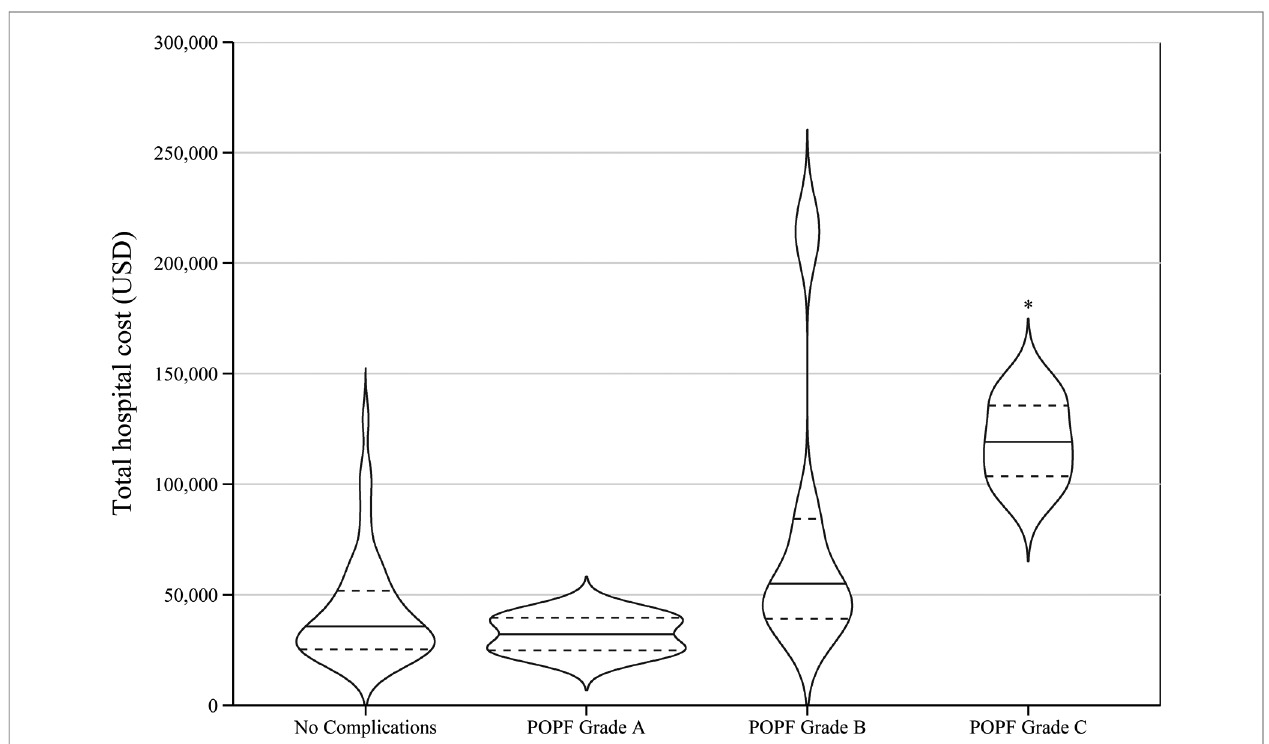
FIGURE 4 | Unadjusted hospital cost according to the grade of postoperative pancreatic fi stula. The pancreatic fi stula is graded in agree with the International Study Group for Pancreatic Surgery de fi nition of postoperative pancreatic fi stula. POPF: postoperative pancreatic fi stula. (*: p =0.021 vs. no